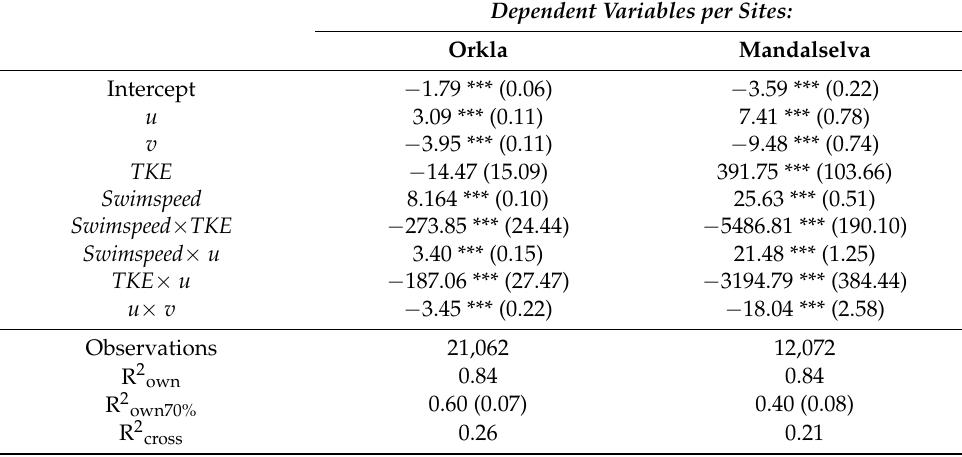
Table 3. Estimated parameters of the best models for angular difference parameterized for the River Orkla site and for the River Mandal site [11]. Parameter estimates are presented for the fixed effect only, with the standard error in parentheses. All R 2 are calculated by comparing observed values vs. predicted values for the models, and R 2 own70% is calculated by parameterizing the model on 70% of the individuals and compare the observed vs. predicted for the remaining 30% of the individuals. R 2 own is the R 2 of angular difference when the model was parameterized and tested on the same river site, while the R 2 cross is the R 2 for the models parameterized on one site and tested in the other site. Dependent Variables per Sites: Orkla